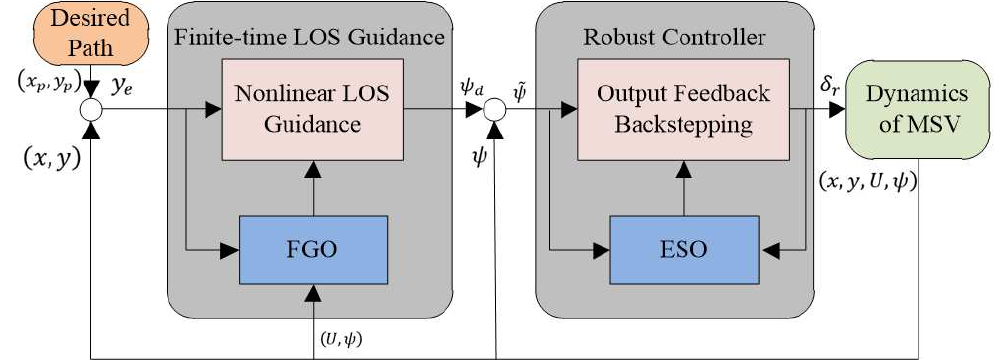
Figure 2. The control